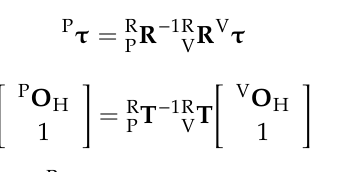
Figure 6. The color image and the depth image. 3.1.2. Trajectory Planning for Visual Locating During the visual location procedure, the trajectory planning of the robot is produced by position control. The trajectory planning can be divided into three parts, as shown in Figure 7. The